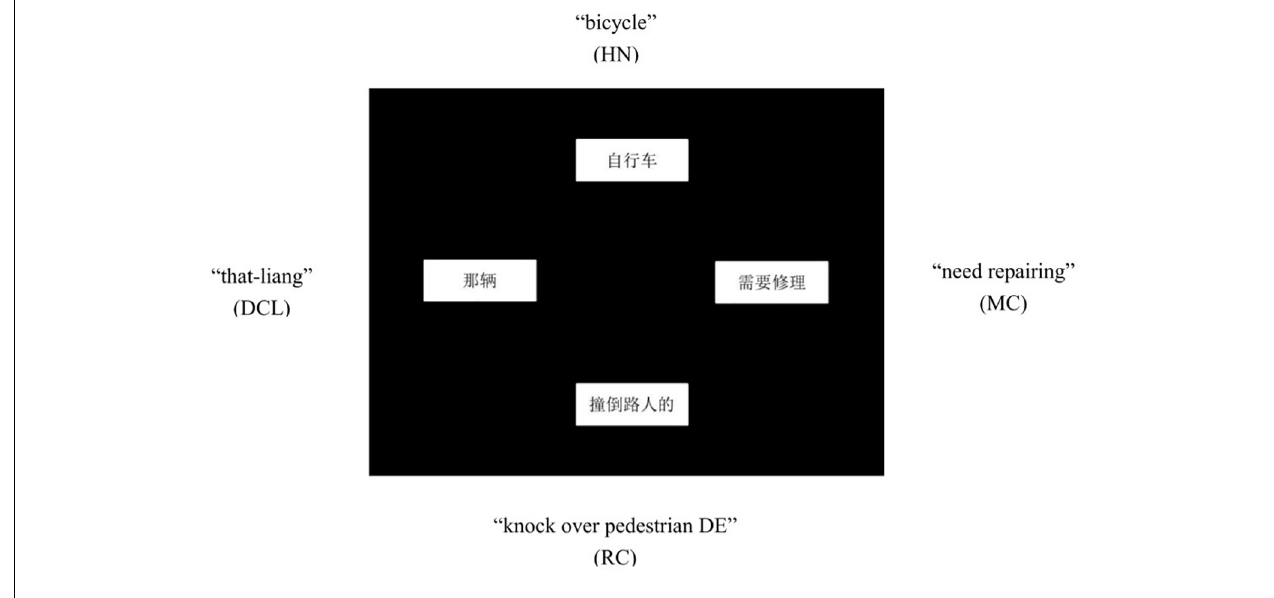
FIGURE 1 | An example of the visual display.